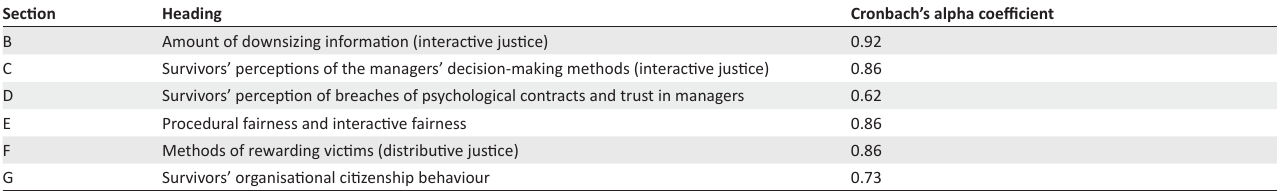
TABLE 1: Cronbach’s alpha coefficient for testing the reliability of the questionnaire.